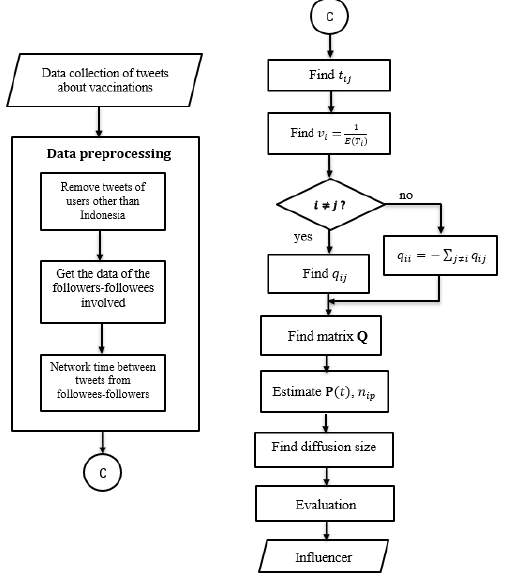
Fig 3. Flowchart of Information Diffusion Model with